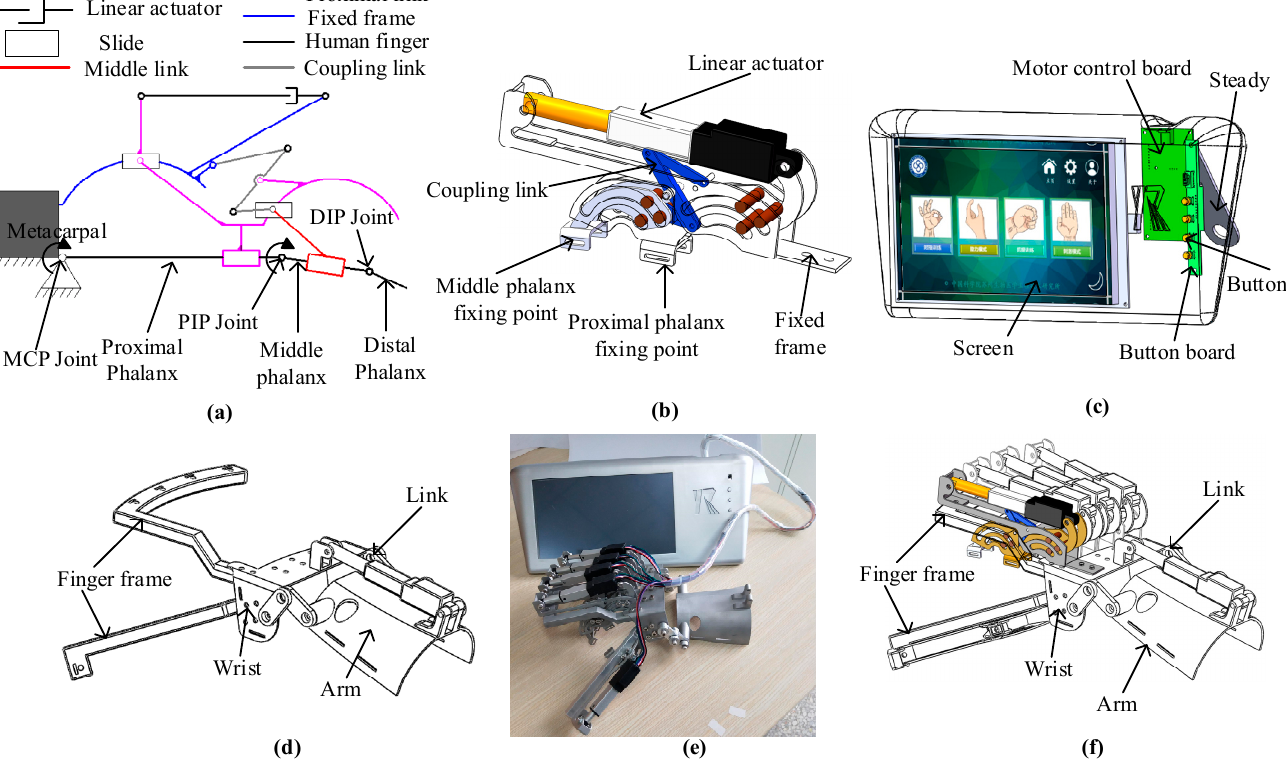
Figure 1. Overall design of exoskeleton hand rehabilitation robot. ( a ) A simplified model of single finger structure with joint linkage; ( b ) structure design of rehabilitation training for single finger; ( c ) composition of control host, interactive interface and control hardware; ( d ) frame design for finger mounting; ( e ) assembled whole robot; ( f ) the whole structure of hand rehabilitation